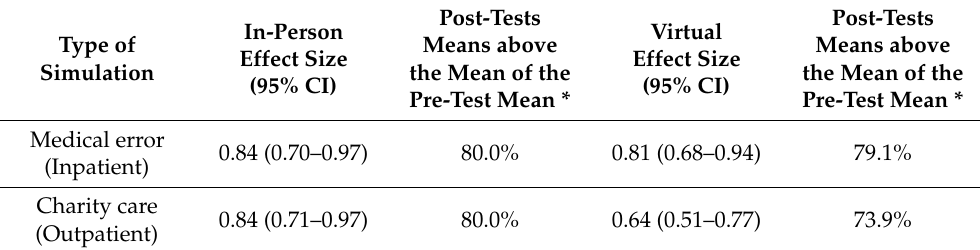
Table 3. Effect sizes comparing the pre-test and post-test of the in-person simulation and the vir- tual simulation from August 2019 to May 2020, calculated as Cohen’s d for independent samples (Basic